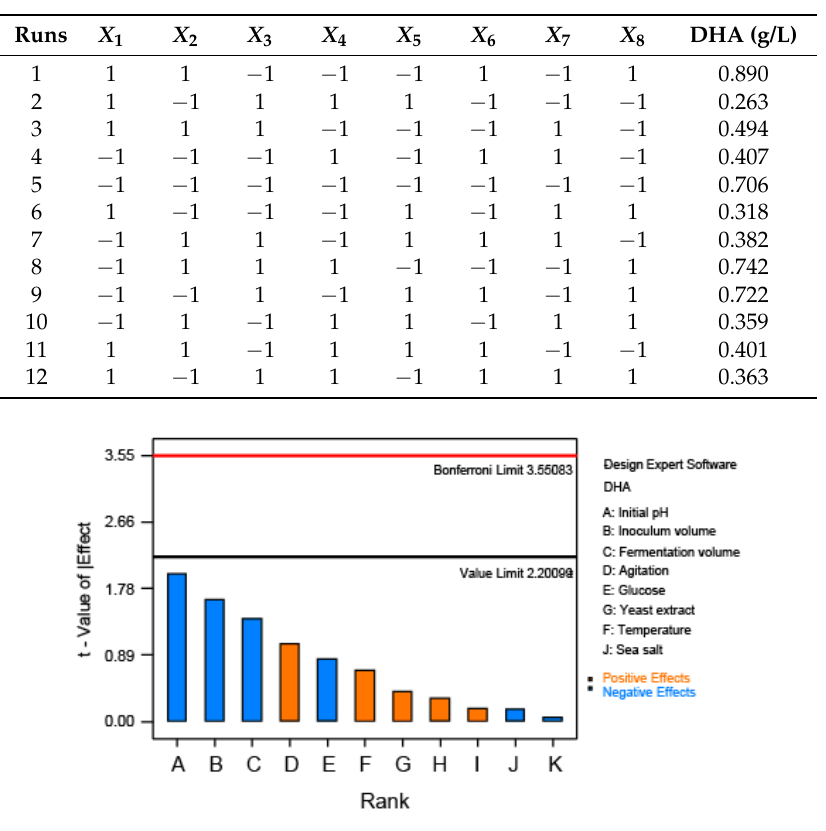
Figure 1. Pareto chart of each factor standard effects on DHA production.